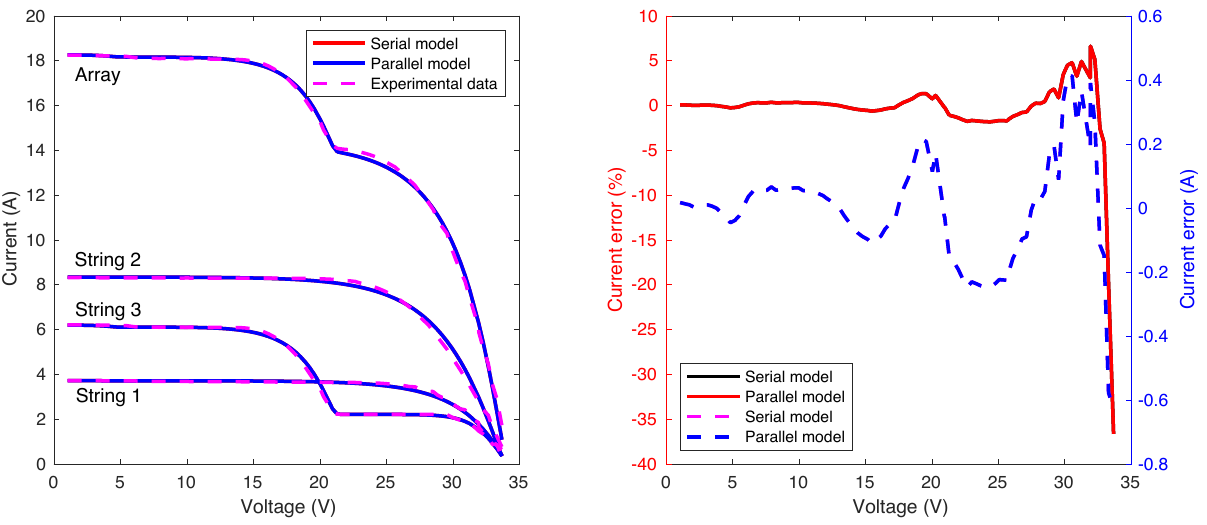
Figure 8. I-V curves ( left ) and current errors in A and % ( right ) of a 3 × 3 array under partial shading